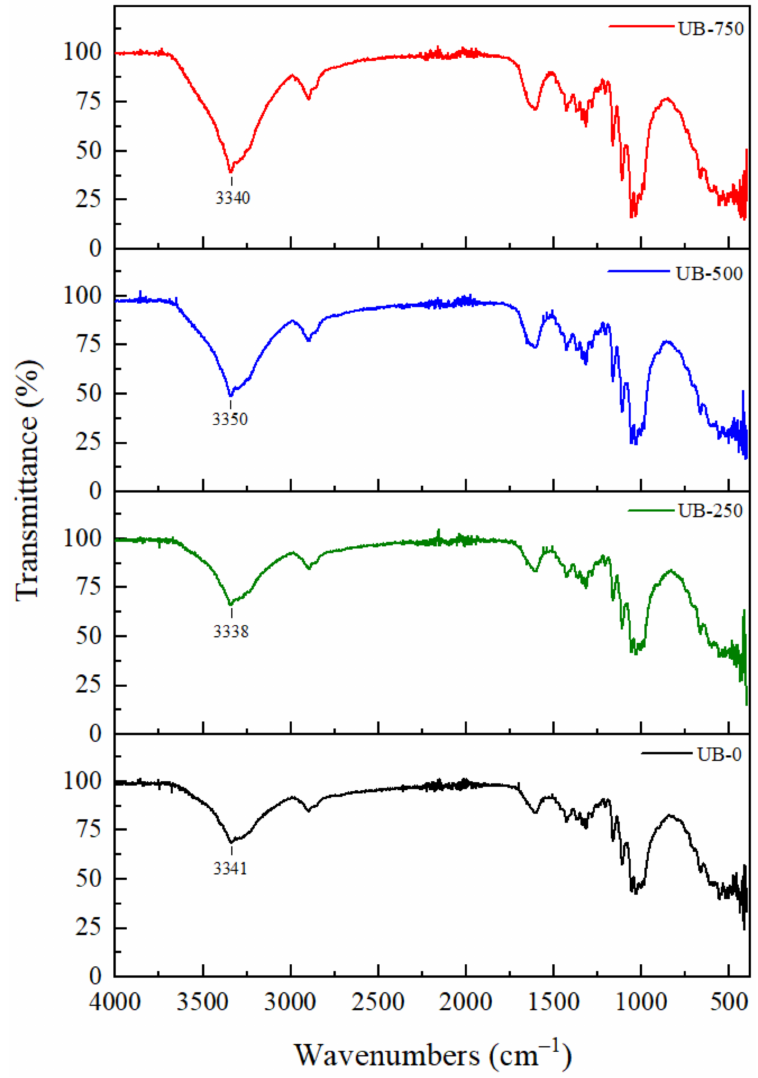
Figure 3. Effect of different ultrasonication powers on the FTIR